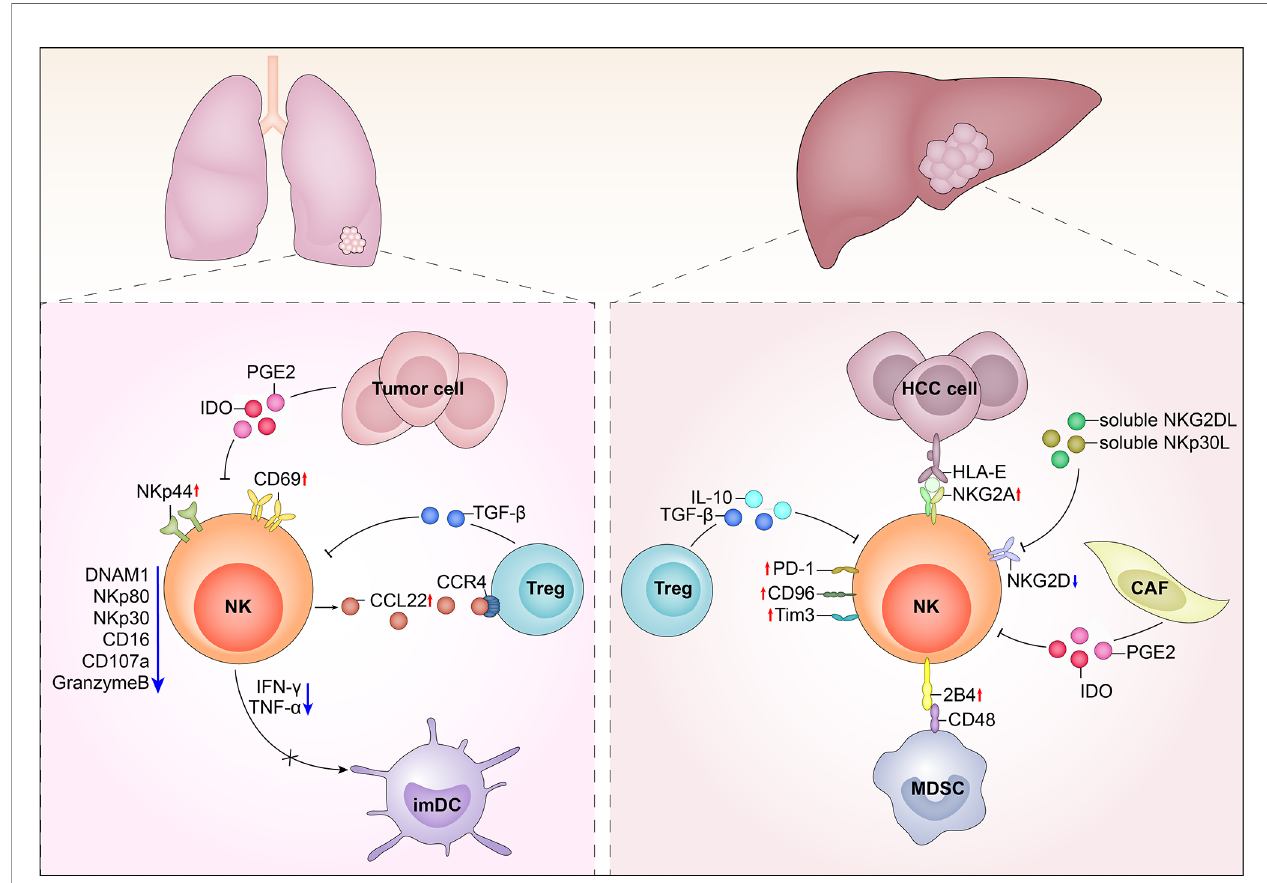
FIGURE 1 | Tumor in fi ltrates NK cells in hepatocellular carcinoma (HCC) and lung cancer. Left image: In the tumor microenvironment of lung cancer, NK cells up- regulated the expressions of CD69 and NKp44 and down-regulated the expression of NKp30, NKp80, DNAM-1 and CD16. Series of soluble molecules were secreted by tumor cells, like IDO, PGE2, and TGF- b . Tumor cells also could express membrane molecules that can shed receptors on the surface of NK cells. In addition, intratumoral NK cells showed impaired IFN- g secretion, which may lead to inef fi ciency in DC maturation. Right image: In the tumor microenvironment of HCC, NK cells up-regulated KIR, NKG2A, PD1, TIM2, and CD96 inhibitory receptors while down-regulated NKG2D. Treg cells produced IL-10 and TGF- b . In HCC, TGF b , prostaglandin E2 (PGE2) and indoleamine 2,3-dioxygenase (IDO), produced by tumor-associated fi broblasts inhibit the cytotoxic activity and cytokine secretion of NK